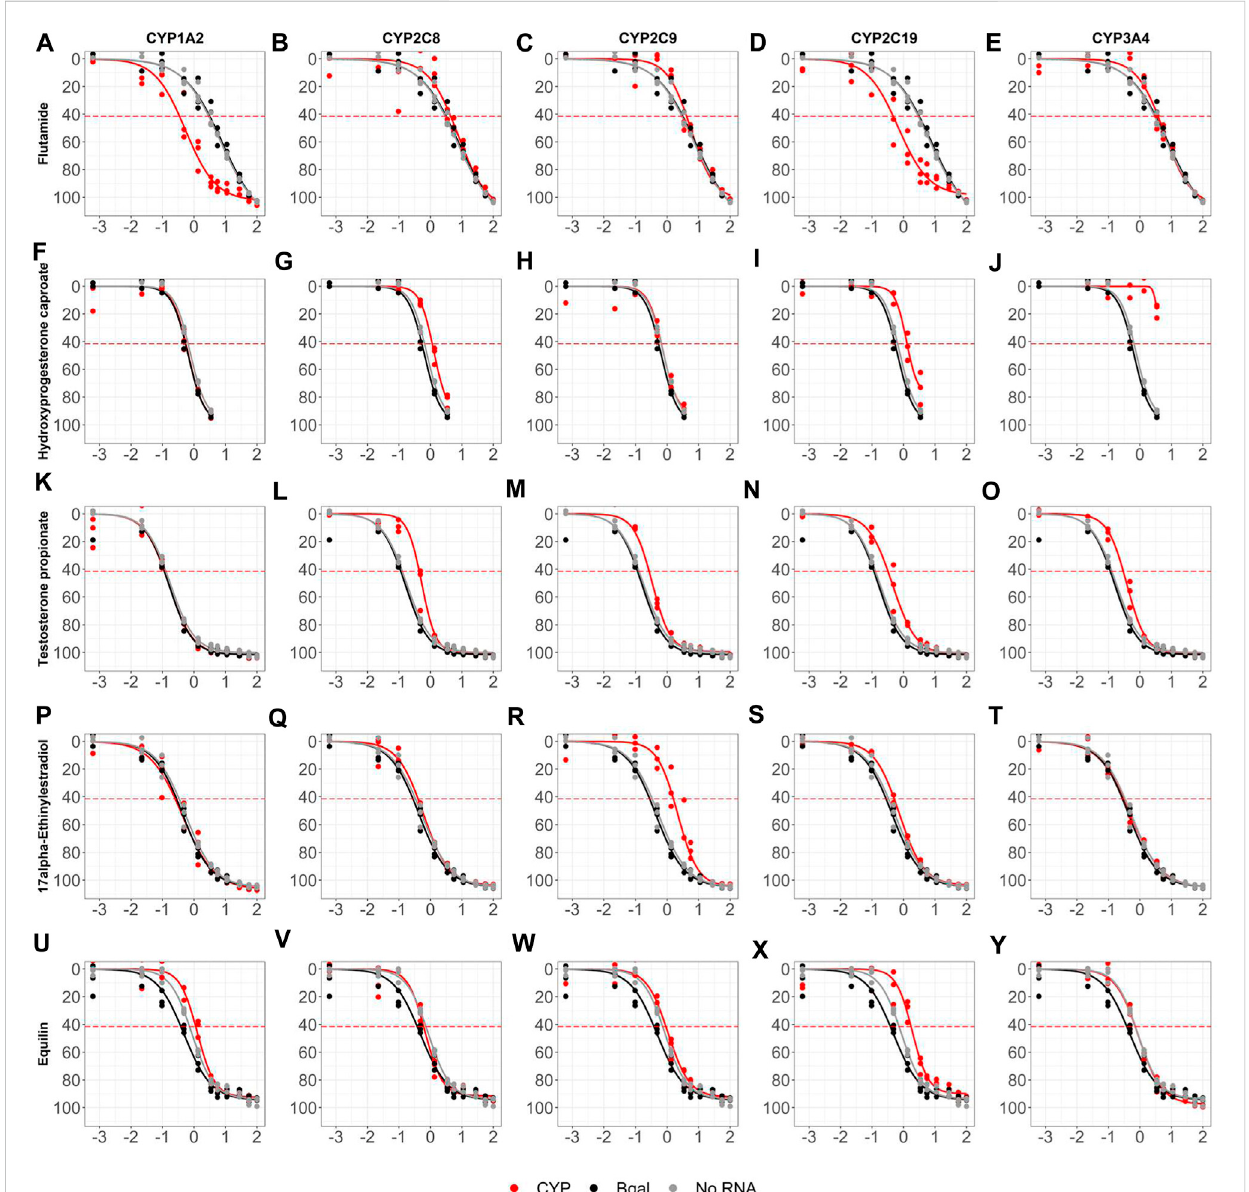
FIGURE 7 Sampleretro fi ttedantagonistconcentration-response curvesfor 128 evaluationchemicals.AR2cellsweretransfected withmRNAsencodingbeta- galactosidase(black),oneoftenhumanCYPenzymes(red),ornoRNA(grey)for6hoursthenexposedto128uniquechemicalsatconcentrationsranging from691pM-99.9 μ Mfor18hoursinantagonistmode.Shownarethedose-responsepro fi lesforFlutamide (A – E) ,Hydroxyprogesteronecaproate (F – J) , Testosterone propionate (K – O) , 17 α -Ethinylestradiol (P – T) and Equilin (U – Y) in cells expressing one of fi ve CYP enzymes: CYP1A2 (A,F,K,P,U) , CYP2C8 (B,G,L,Q,V) , CYP2C9 (C,H,M,R,W) , CYP2C19 (D,I,N,S,X) and CYP3A4 (E,J,O,T,Y) . Micromolar concentrations are expressed as log 10 (x-axis). Responses are expressed as % inhibition (% maximal positive control). Concentration-response curves were fi t using tcpl_Lite. The red dotted lines represent the activity thresholds de fi ned as 3 x bmad. Data represent individual wells from three independent experiments. The antagonist response curves for all 128 chemicals tested across all ten CYP enzymes can be found in Supplementary Figure